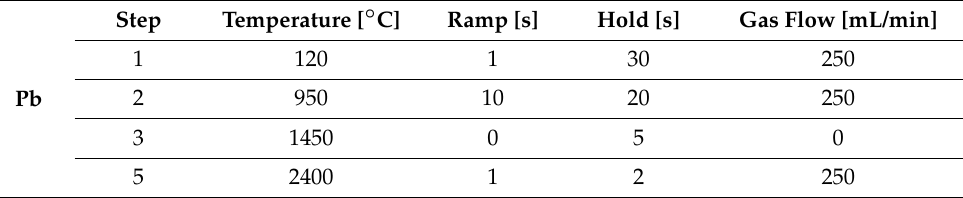
Table 2. Time–temperature program in the graphite furnace atomic absorption spectrometer for Pb and Cd